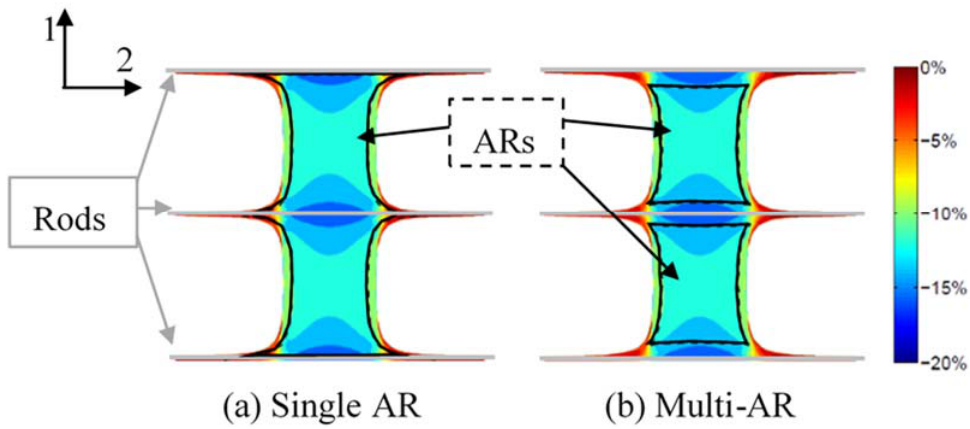
Figure 12. Thickness strain distribution of a deformed RP-DEA from 2D finite element simulation. The thickness is evaluated from in-plane residual strains ε 11 , ε 22 according to Equation (17) ( h “ 0.1 mm).